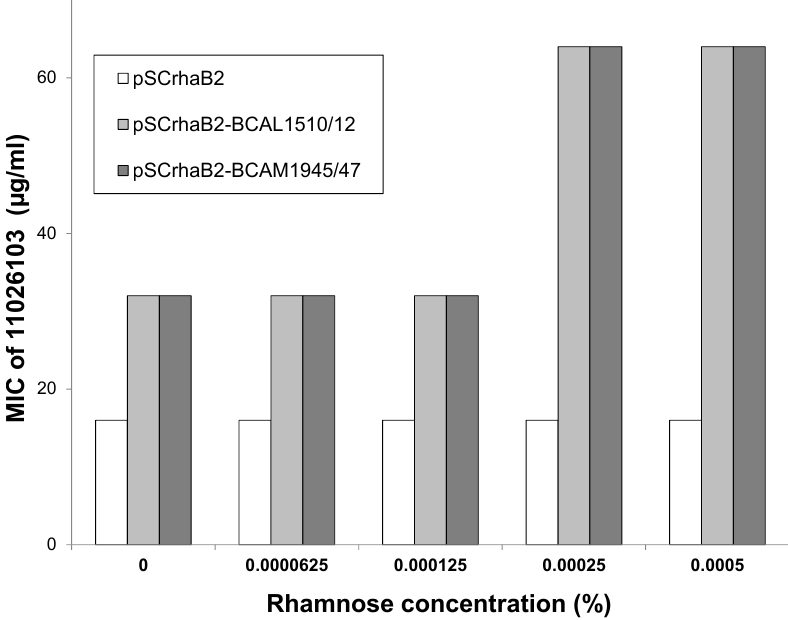
Figure 3. The e ff ect of artificial expression of e ffl ux systems BCAL1510-1512 (MFS) and BCAM1945-1947 (RND-9) in B. cenocepacia J2315 on MIC of 11026103. MICs were determined in media containing increasing concentrations of expression inducer (L-rhamnose) up to 0.0005% ( w / v ). Rhamnose concentrations of 0.001% ( w / v ) and higher impaired viability of bacteria overexpressing both e ffl ux systems, regardless of the presence of